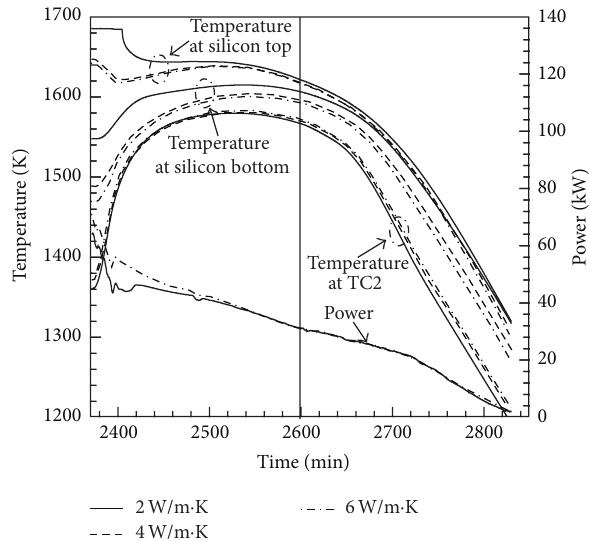
Figure 6: Evolution of process parameters during the annealing and cooling stages for DS processes with different crucible thermal